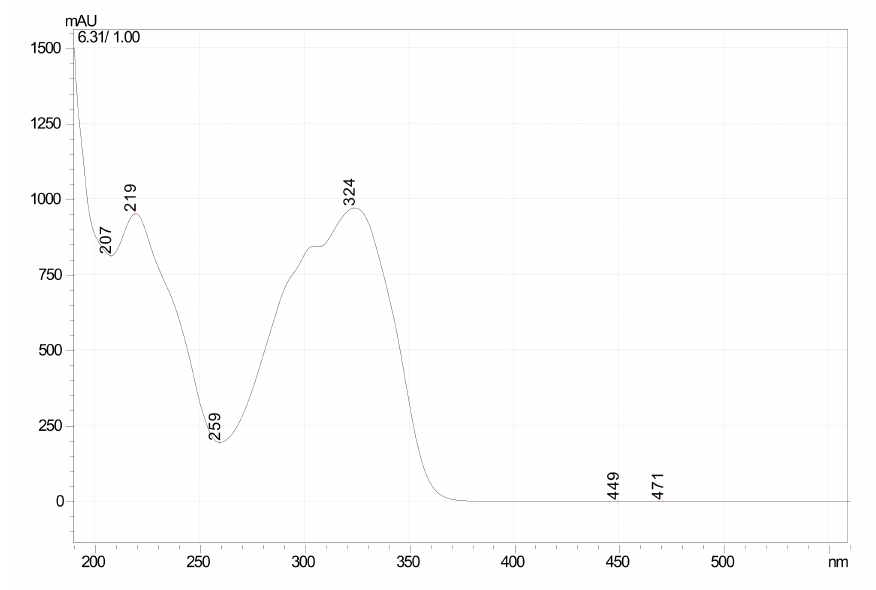
Figure 2. UV-spectrum of oxyresveratrol (UV λ max-219 nm, 324